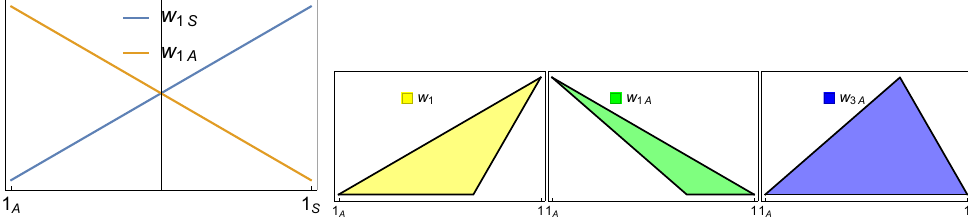
Figure 13. Left: the w α values on the 1 A − 1 S edge. Only w 1 S and w 1 A are nonzero. Right: the w α values on the 1 A − 1 edge. Only w 1 , w 1 A and w 3 A are nonzero. The shaded regions are their allowed range. ~C is always normalized such that 2 C